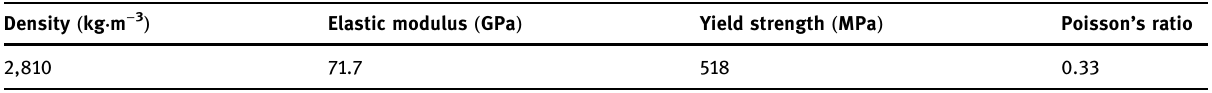
Table 2: Properties of 7075 - T6 Al